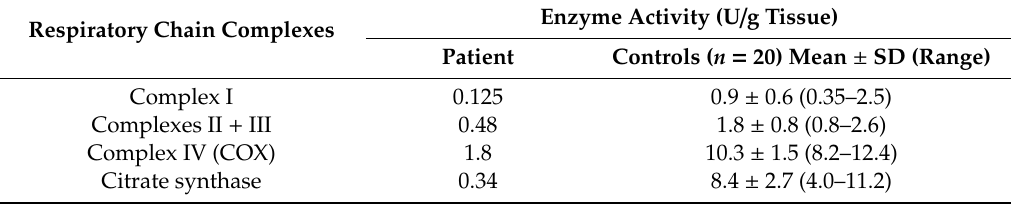
Table 1. Enzyme activity of respiratory chain complexes, showing decreased activities of respiratory chain complexes I, II + III and IV, as well as decreased citrate synthase activity in the patient